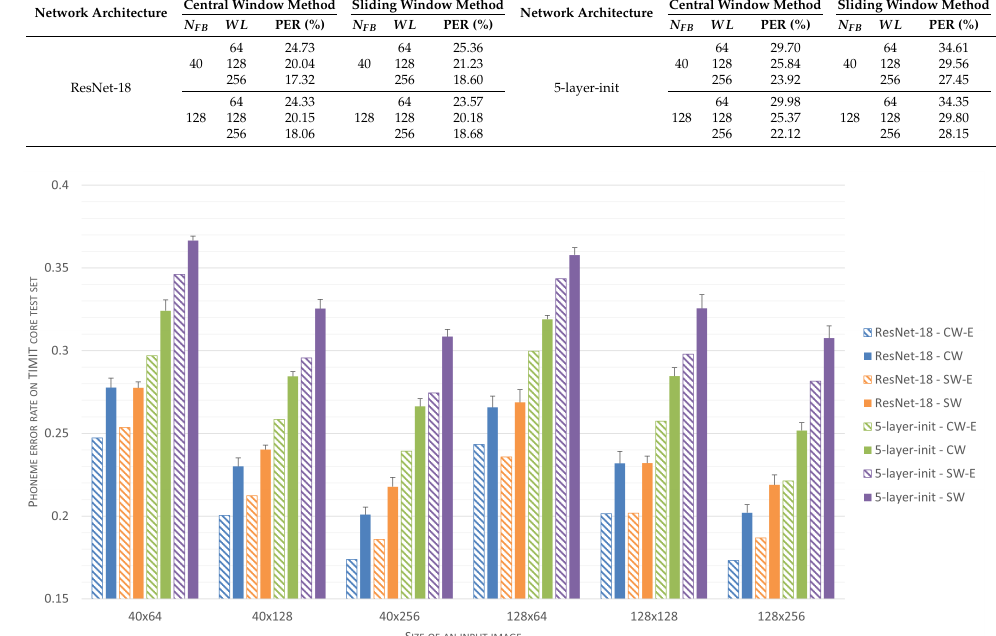
Table 5. Performance of classifier ensembles (ResNet-18 and the simple unoptimized CNN).